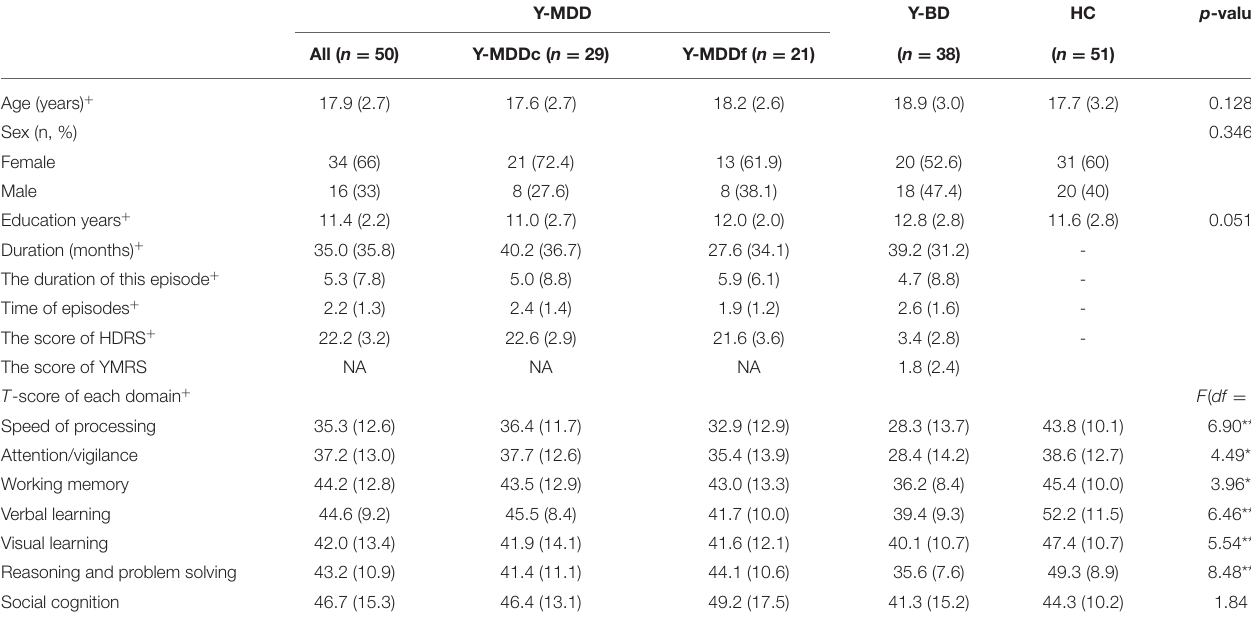
TABLE 1 | Demographic characteristics of each group.